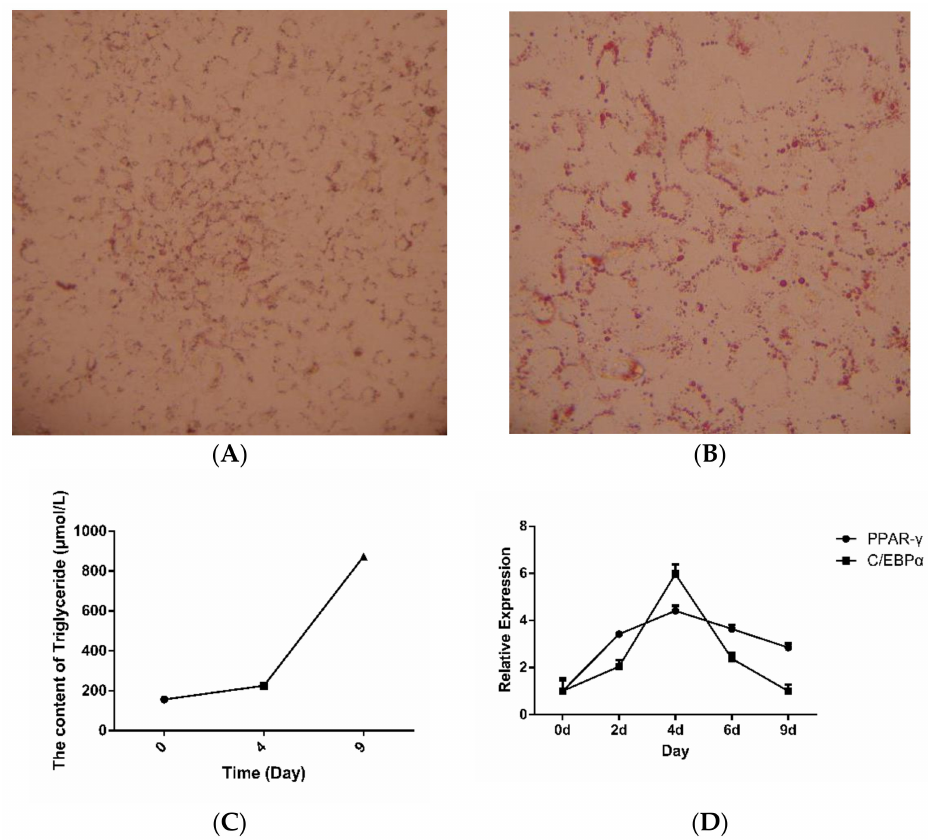
Figure 1. Isolation and identification of pre-adipocytes from Yan Yellow cattle. Undifferentiated cells isolated from Yan Yellow cattle and cultured in medium containing 10% Fetal Bovine Serum (FBS) and stained with Oil-Red O on day 9 post differentiation. ( A ) Identification of the adipocytes with Oil-red O staining, 100 × ; ( B ) identification of the adipocytes with Oil-red O staining, 200 × ; ( C ) the contents of the triglycerides were significantly improved with the progression of adipogenesis; ( D ) the relative expression of adipogenic marker genes refers to refers to 2 − ddCt with beta-actin as housekeeping control